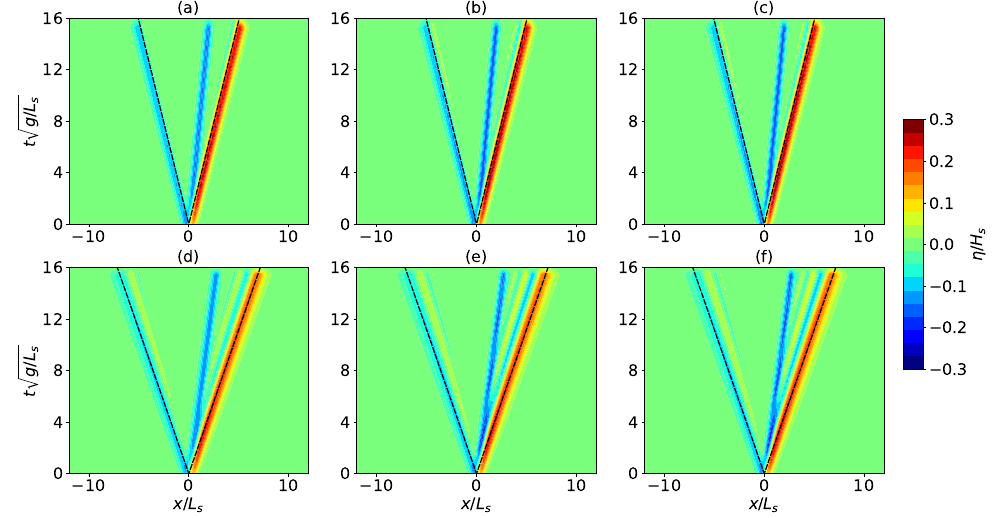
Figure 4. Comparison of the wave-field contours obtained from three different wave models: ( a , d ) NH-1L model, ( b , e ) LWD model, ( c , f ) LFD model, for ( a – c ) µ = 0.1, ( d – f ) µ = 0.2. The dashed line represents the characteristic curves with wave celerity ±